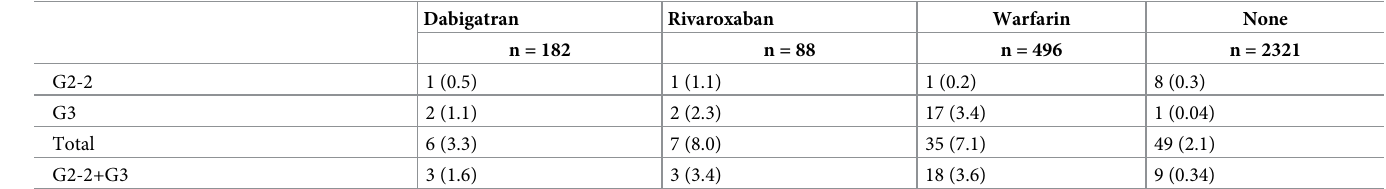
In the dabigatran group, no risk factor for hemorrhage after extraction was detected in either the univariate or multivariate analyses (Tables 3 and 4). In the rivaroxaban group, P- values < 0.2 were observed in the univariate analysis for the use of nerve blocks to the inferior alveolus, as well as for gingival inflammation at the extraction site. In the multivariate analysis that was performed using these factors as explanatory variables, the extraction technique (OR: 25.808, P = 0.039) and the use of nerve block injections to the inferior alveolus (OR: 31.606, P = 0.044) emerged as risk factors for hemorrhage after extraction (Tables 3 and 5).